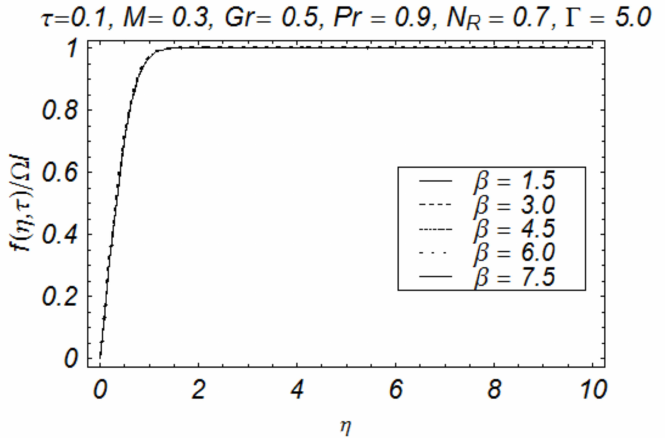
Figure 8. Indication of β on primal